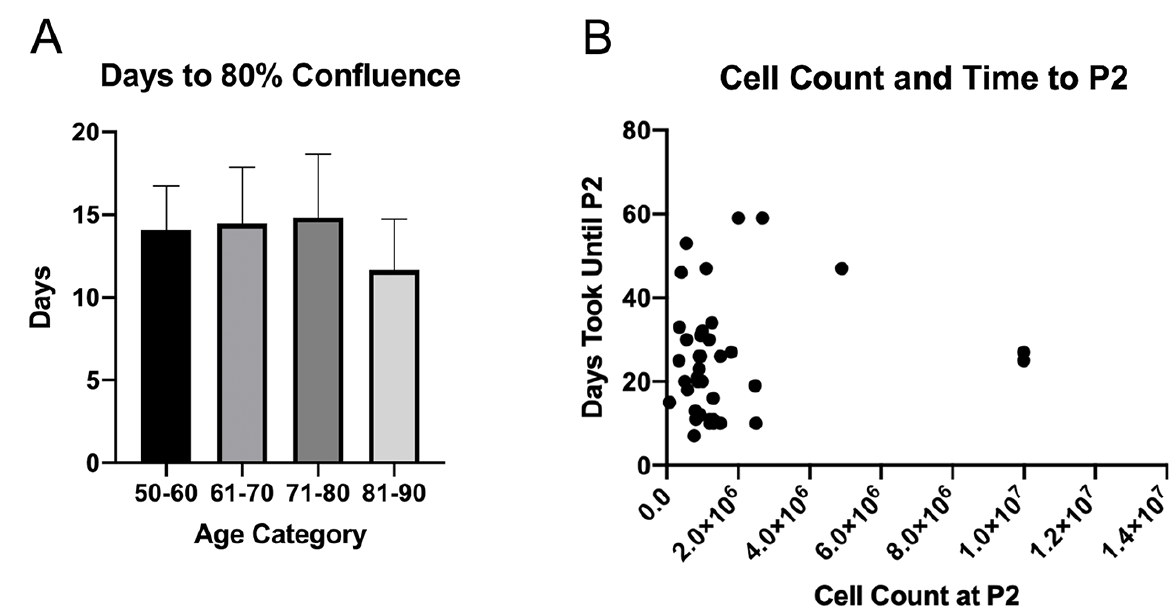
Figure 4. ( A ) Time taken for MSCs to reach 80% confluency since the date of collection stratified based on age groups (50–60, n = 9; 61–70, n = 19; 71–80, n = 19; 80–90, n = 3). ( B ) Cell count at the time of P2 and amount of time until P2 split of MSCs.